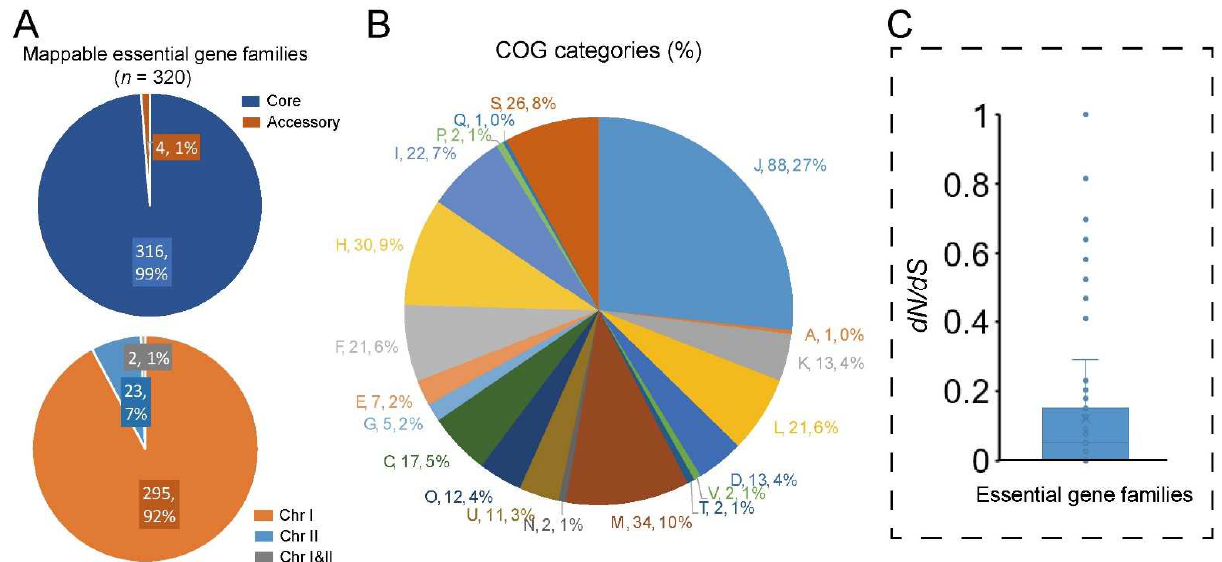
Figure 5. Analyses of the potential essential gene families in V. cincinnatiensis: ( A ) distribution of the potential essential gene families in pan-genome and chromosome location; ( B ) distribution of COG functional categories for the potential essential gene families; ( C ) the dN / dS rates of the potential essential gene families.